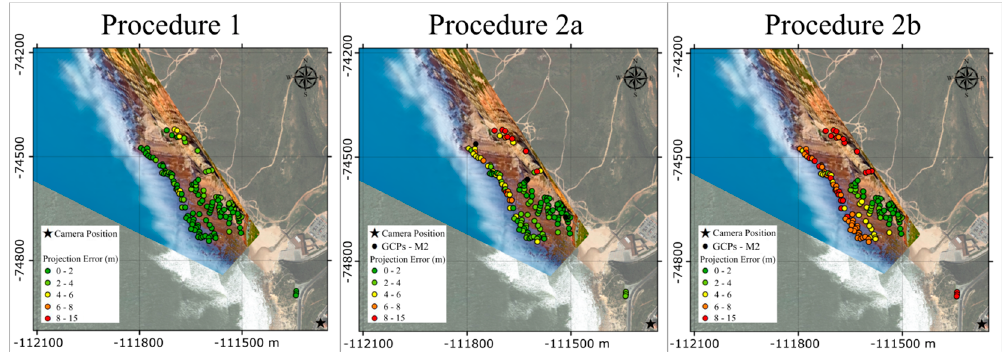
Figure 9. Rectified planar images generated by C-Pro Procedures, plotted on a basemap of the area with local system (ETRS89—Portugal TM06). Images are projected with the Z elevation value equal to the tidal level at the corresponding image time. Colored dots represent the horizontal projection error of the 134 checkpoints. Colorbar scale is common to all images.